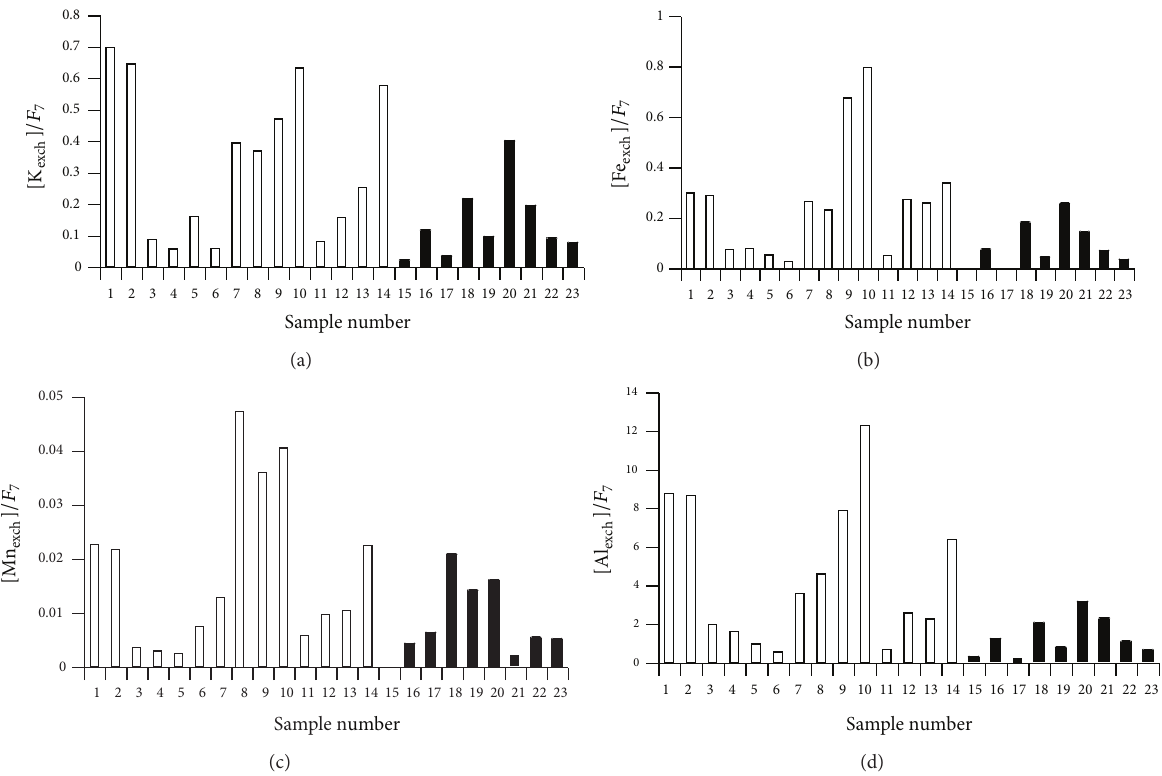
Figure 5: Molar ratios of selected metals in exchangeable complex in soil samples collected in Istebna (in white) and Bukowiec (in black).